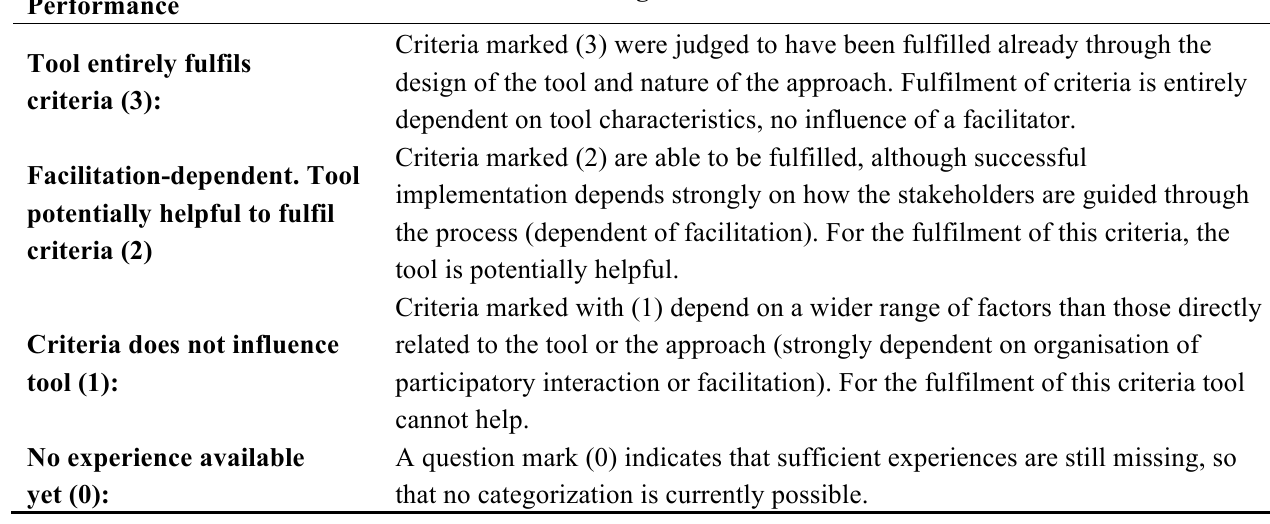
Table 2. Categories and details for categorisation of tool performance against pDSS evaluation